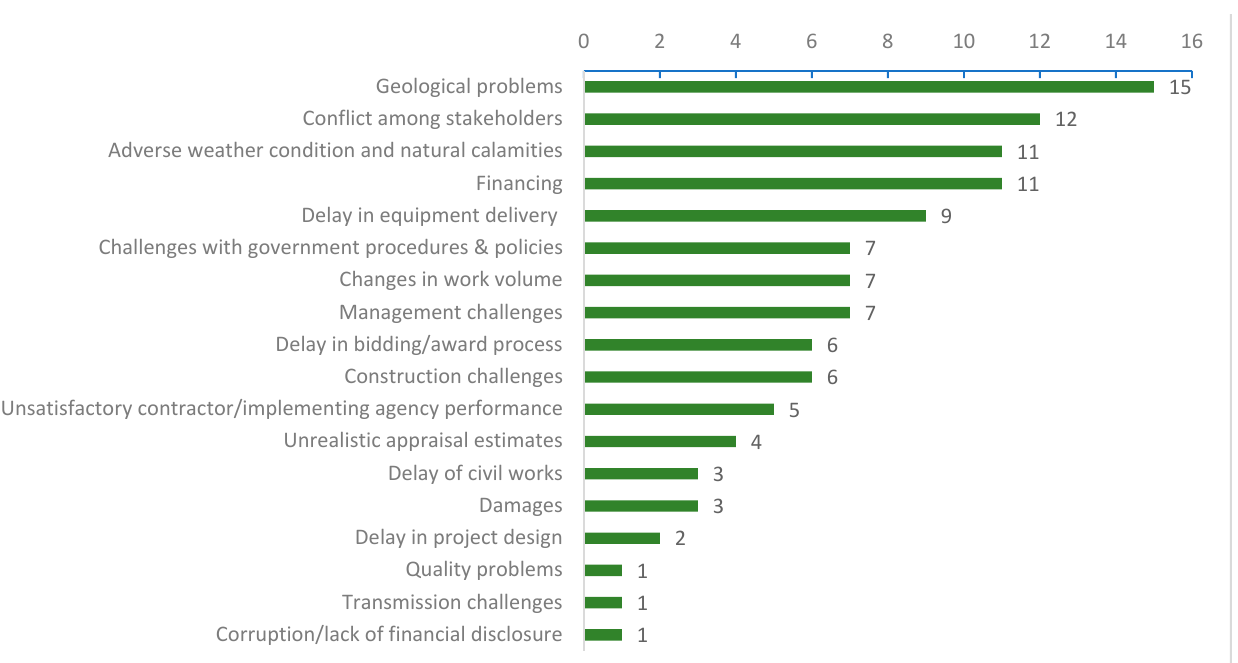
Figure 1. Causes of cost overruns (summary).